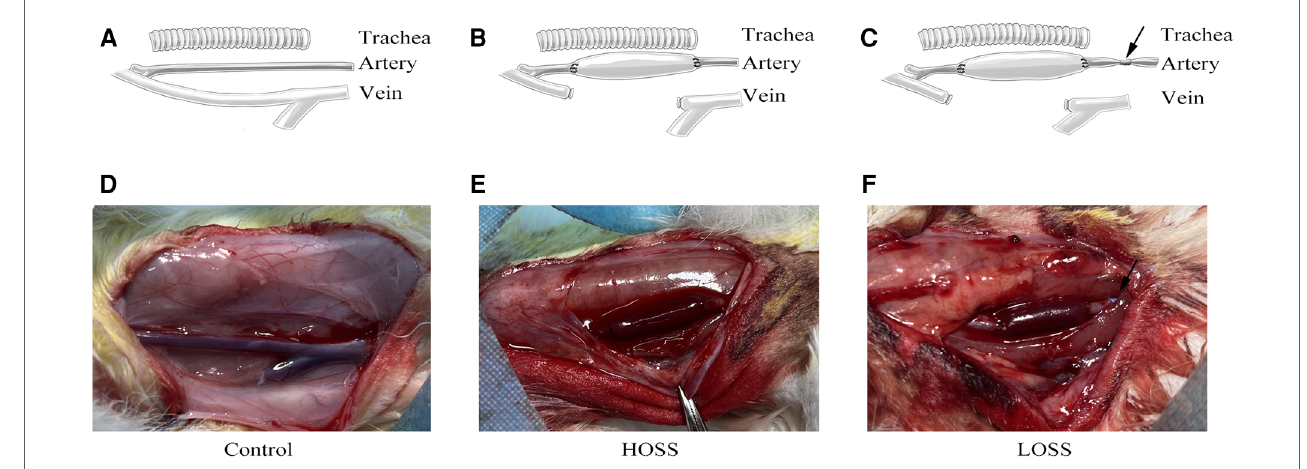
FIGURE 1 Surgical grouping and model construction. Rabbits were randomly divided into three groups: ( A,D ) control group (exposed vessels only), ( B,E ) high-oscillatory- shear-stress (OSS; HOSS) group (external jugular vein grafted to the ipsilateral common carotid artery), and ( C,F ) low-OSS (LOSS) group (vessels ligated to 50% – 70% lumen area using a sheath at 5 mm of the in fl ow tract artery after vein grafting). N =10 per group. Black arrow: 5F vascular sheath